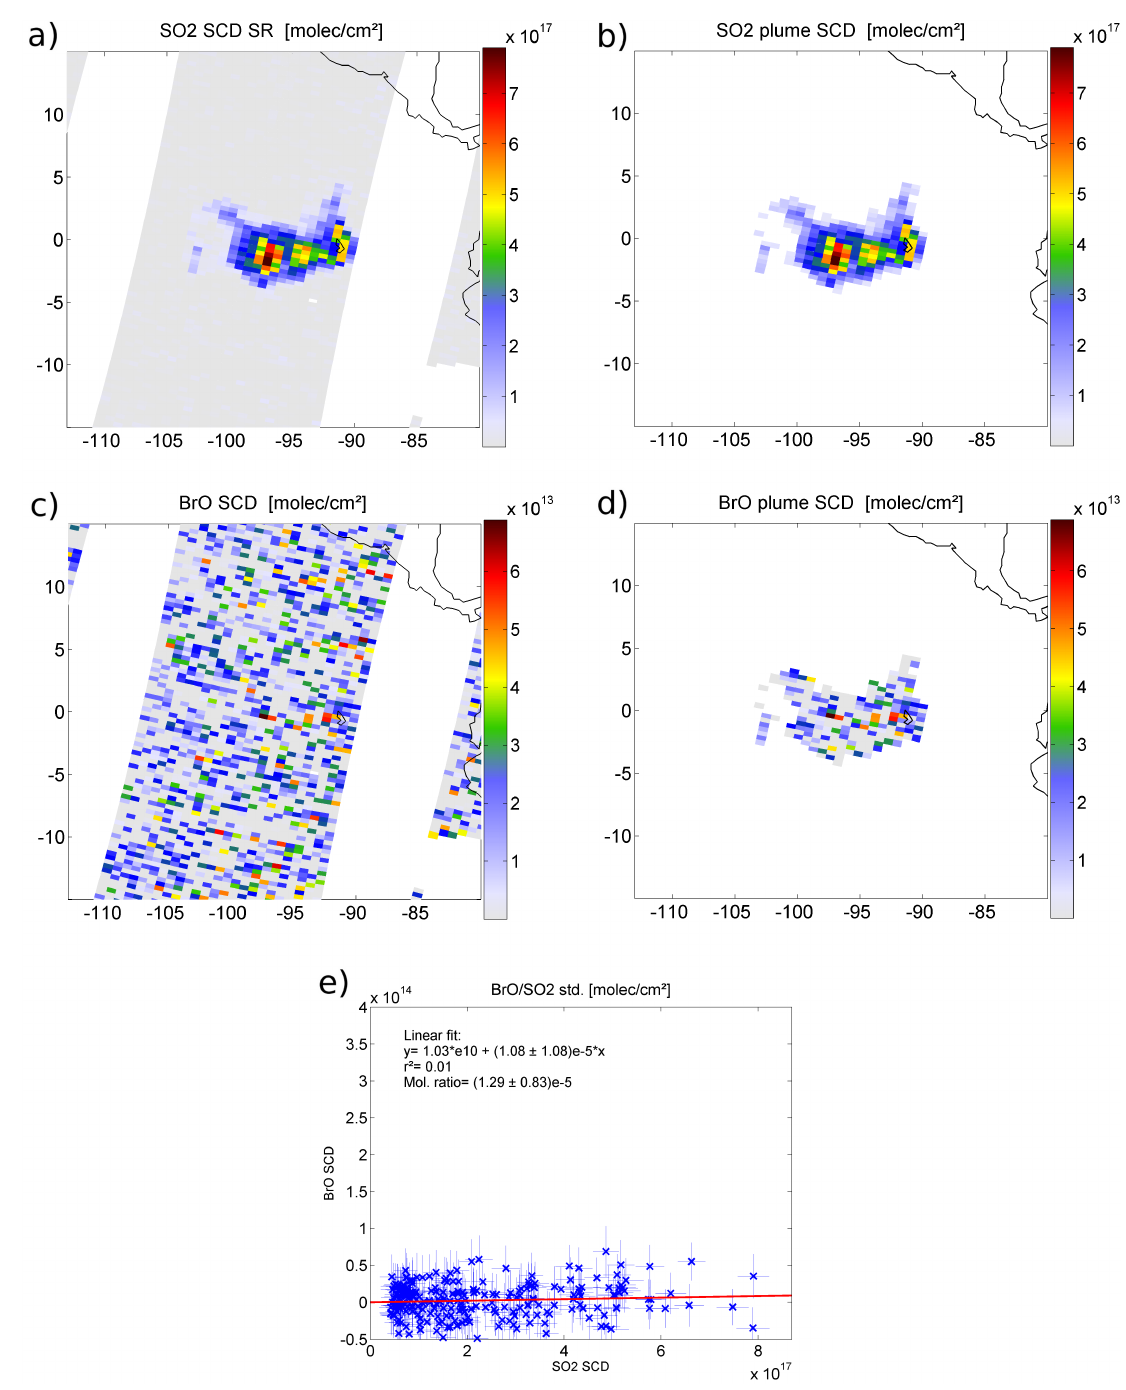
Fig. 16. SO 2 and BrO SCDs for the eruption of the Fernandina volcano (Galapagos Islands, Ecuador) on 13 April 2009. The background corrected SCDs ∗ for SO 2 and BrO are shown ( a and c ), including the pixels of the PEB and the reference area. Accordingly, the extracted plume pixels are shown in (b) and (d) . The resulting correlation plot (e) shows no correlation between the two species as for the majority of all investigated plumes. The BrO SCDs ∗ are statistically distributed over the whole area of the volcanic SO 2 plume, resulting in a vanishing correlation and a BrO/SO 2 ratio close to